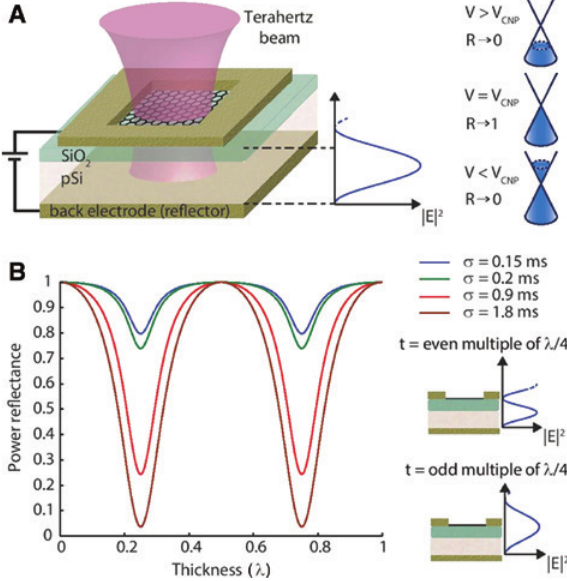
Figure 3: (A) Extraordinary modulation of the reflected terahertz radia- tion is achieved by modulating the Fermi energy of graphene electro- statically along the Dirac cone. (B) When the substrate thickness is an odd-multiple of the THz wavelength, this effect is maximized with the light at the antinode of a standing wave. (Reprinted and adapted with permission from B. Sensale Rodriguez et al. Nano Letters 12, 4518– 4522, 2012, Ref. [53]. Copyright 2012 American Chemical